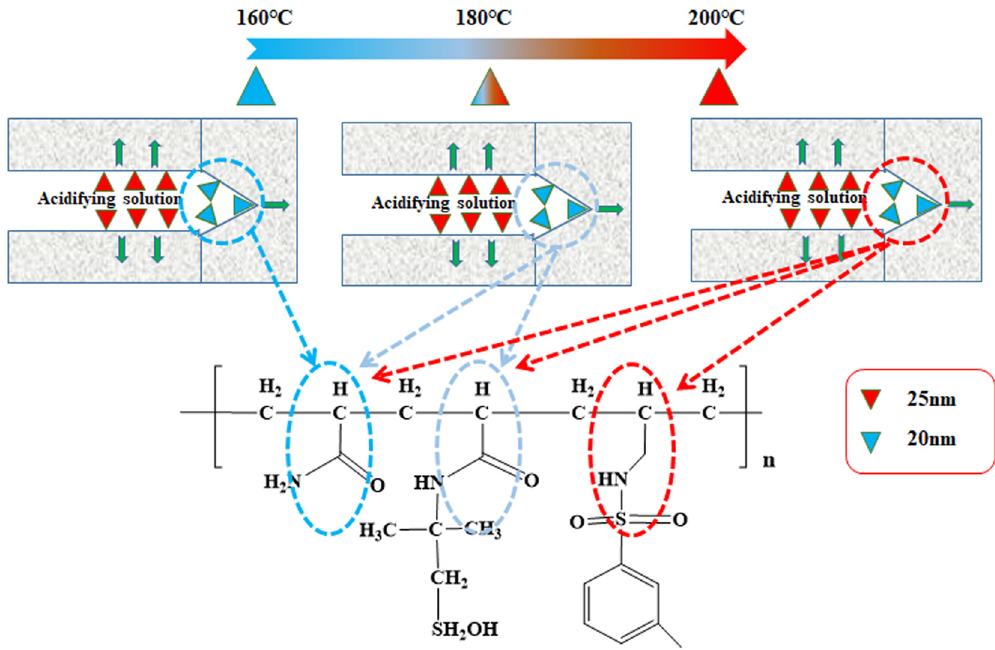
Figure 9: Action mechanism of nano - silica gelling agent at di ff erent reservoir temperatures ( with dimensions )